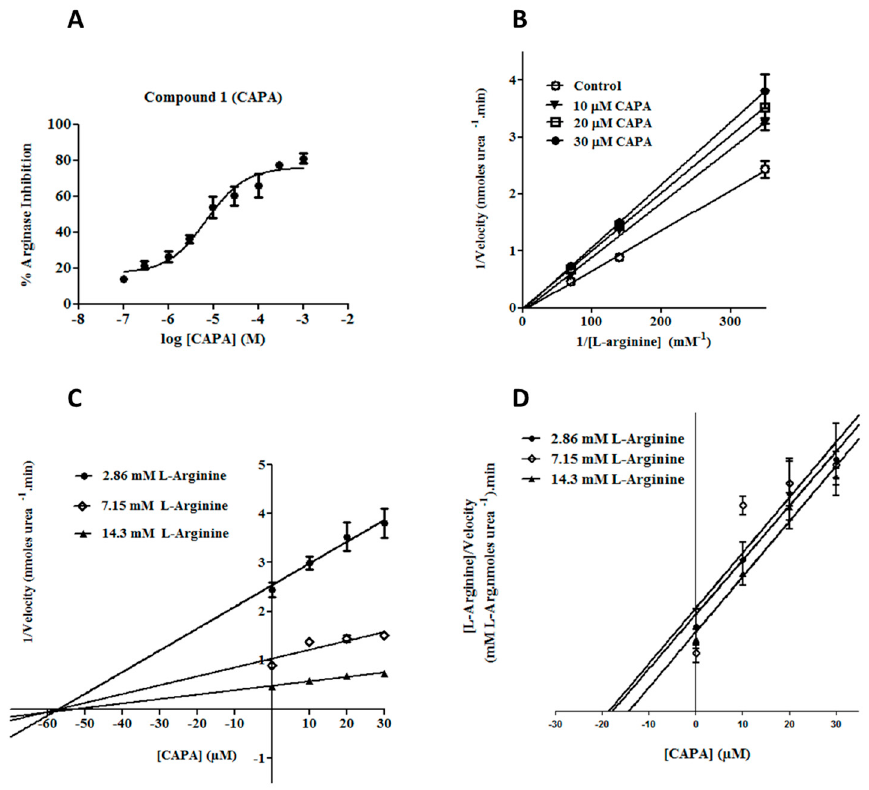
Figure 3. Kinetics of arginase inhibition by 1 (CAPA). The IC 50 was determined from a sigmoidal curve ( A ). The competitive inhibition mechanism was determined by analysis of the: Lineweaver–Burk ( B ); Dixon ( C ); and Cornish–Bowden ( D ) plots. Each data point represents the mean of three in-triplicate independent experiments. Table 2. Comparison of K i values for arginase inhibition by CAPA, CGA and nor-NOHA.